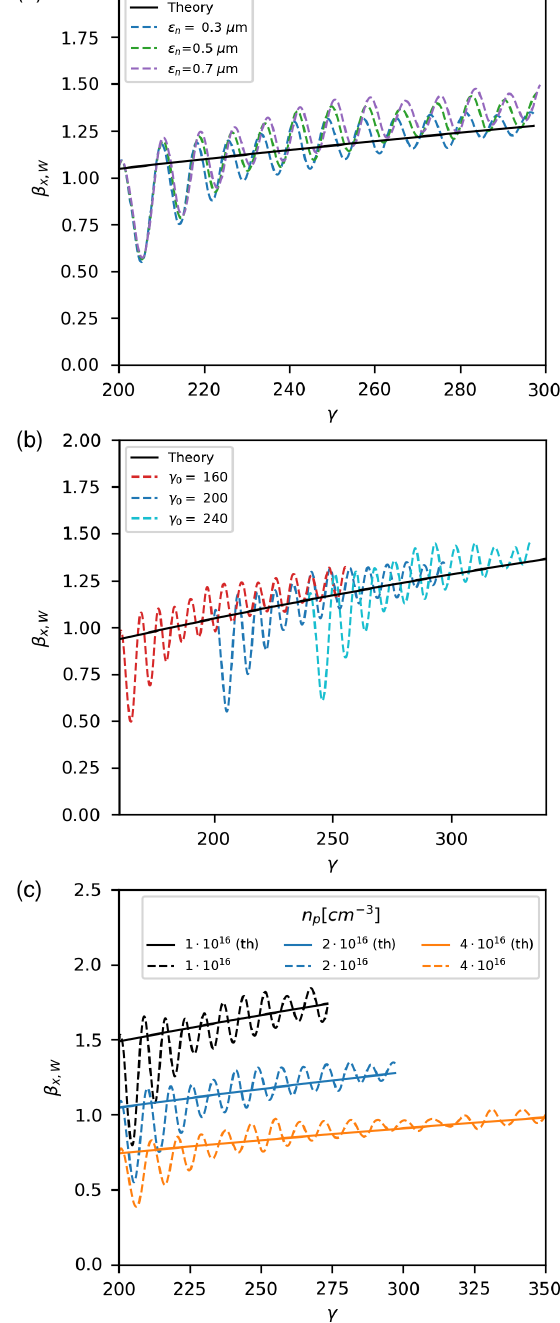
FIG. 6. Evolution of witness β -function versus bunch energy for different working points. In the first working point scan (a) the witness emittance has been varied preserving the β -function at the injection. In the second scan (b) the injection energy of the witness has been varied preserving the β -function at the injection. In the third scan (c) the working point has been redesigned for background plasma densities n p ¼ 1 × 10 16 cm − 3 (black) and n p ¼ 4 × 10 16 cm − 3